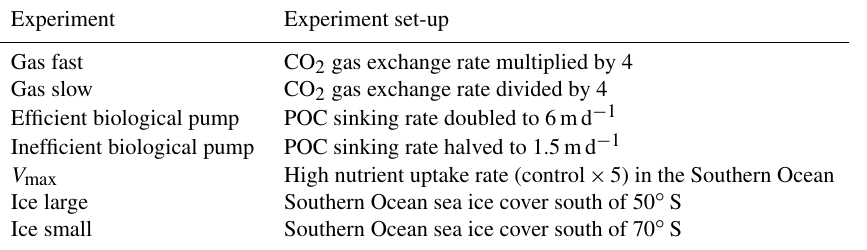
Table 1. Description of the sensitivity experiments. The sensitivity experiments on the CO 2 gas exchange rate and the biological pump have been done twice, once for the Global Ocean and once only making changes in the Southern Ocean (south of 45 ◦